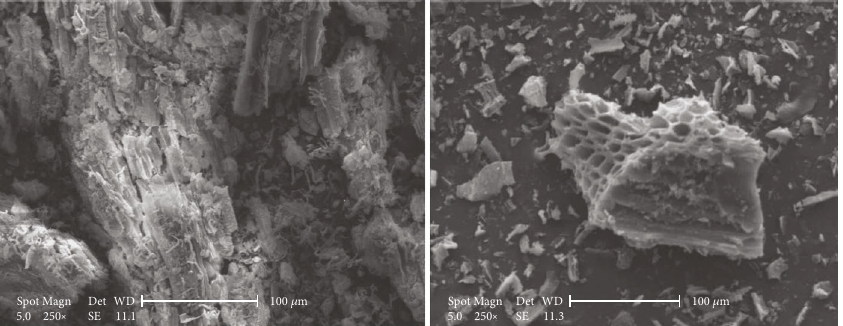
Figure 2: SEM image of prepared AC.